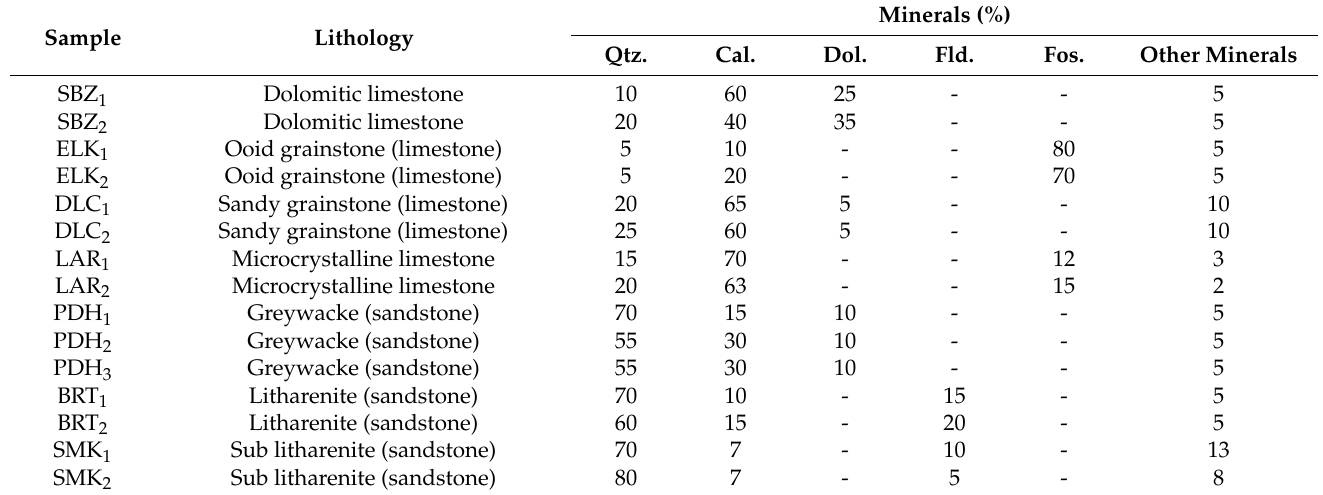
Table 1. Mineralogical and petrographic properties of the studied rock